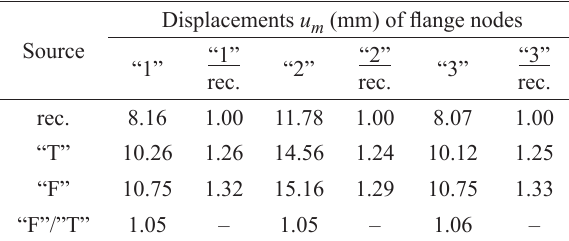
Table 5. Comparison of displacements of rigid flange